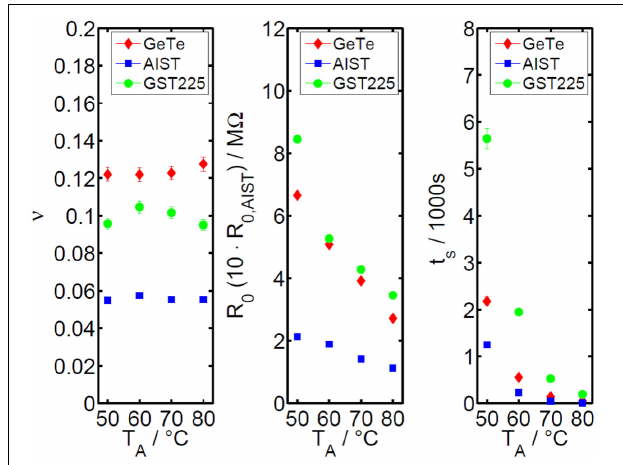
FIGURE 5 | Overview of the extended power law parameters as a function of temperature for GeTe, AIST, and GST. The drift exponent for resistance v (left diagram) is found to be fairly constant for annealing temperatures between 50 and 80 ◦ C. The power law prefactor R 0 (diagram in the middle) shows a decreasing trend with temperature due to the thermally activated conduction in amorphous phase change materials. (The data for AIST are magnified by a factor of 10 in order to enhance the visibility of the decreasing trend). The diagram on the right depicts the virtual age t s as a function of temperature. The lower the difference between storage and annealing temperature, the higher is the virtual age, since the drift effect during storage has a stronger influence at lower annealing temperatures.